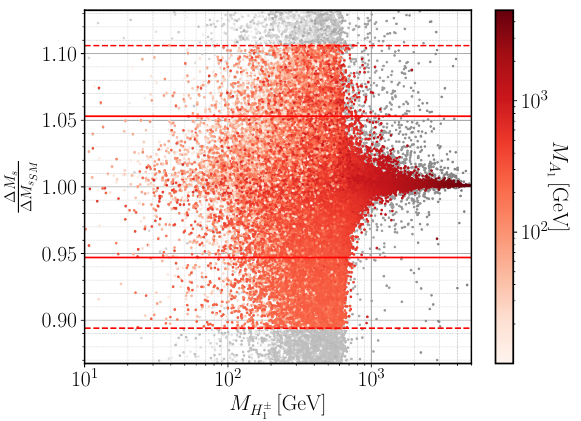
Figure 6 . B s mass difference as a function of the CP-even H 1 and pseudoscalar A 1 masses. The colour code is as in figure 4.